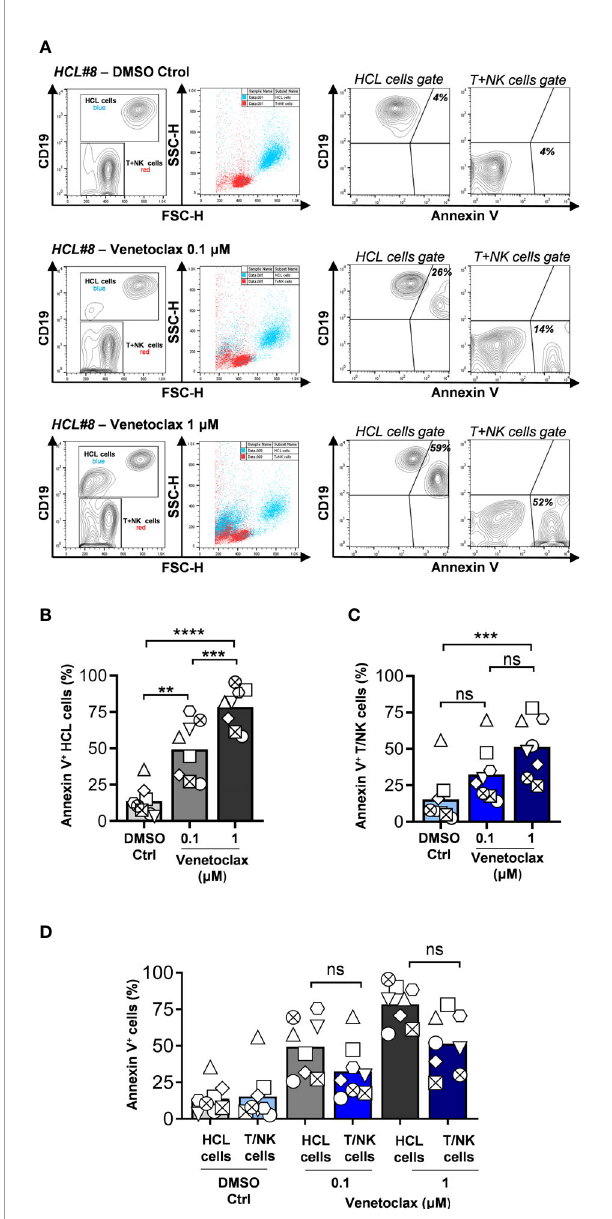
FIGURE 1 | HCL cells are sensitive to venetoclax-induced cell death in vitro . (A) PBMCs were obtained by Ficoll-Paque centrifugation from peripheral blood of eight HCL patients, incubated with venetoclax for 24 h, and cell death was analyzed by fl ow cytometry. Leukemic cells or T + NK cells were discriminated according to CD19 expression and forward side scatter, and next gated to determine binding of Annexin V. Results from a representative sample (HCL#8) are shown. (B) HCL cell death induced by venetoclax for the whole cohort evaluated. (C) T + NK cell death induced by venetoclax for the whole cohort evaluated. (D) Comparison of cell death induced in HCL cells and T + NK cells. For all the group graphics, each symbol represents a single patient (n = 8, **p < 0.01, ***p < 0.001, ****p < 0.0001, paired one-way ANOVA using correction for (B) and Friedman test followed by Dunn ’ s multiple comparisons test for (C, D) , ns, not signi fi